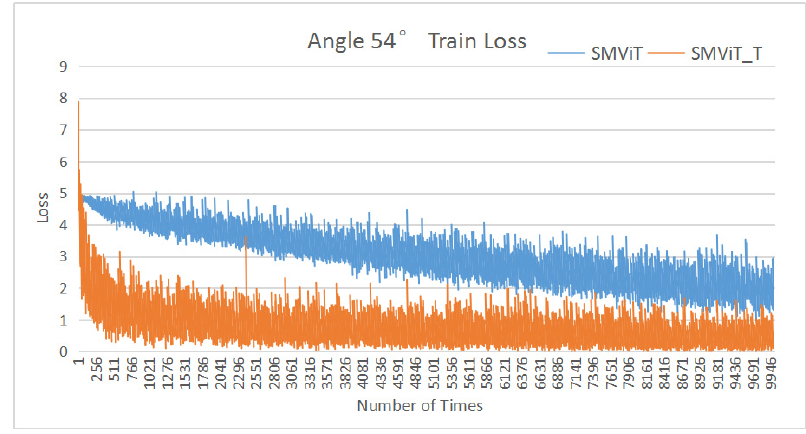
Figure 5. Loss change when the view is 54 ◦ .